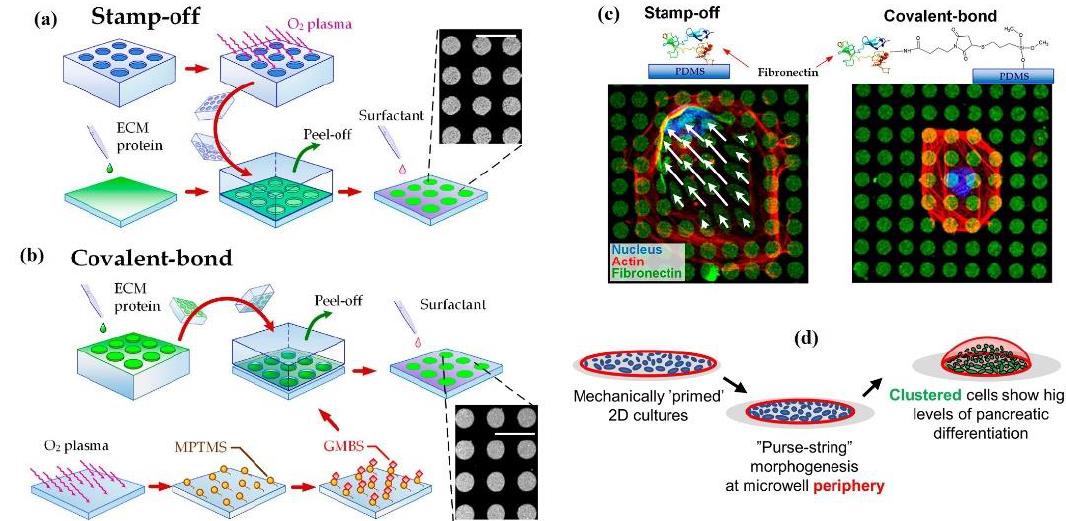
Figure 5. Micropatterning . ( a ) Microcontact printing ( μ CP) of ECM proteins for achieving different protein–substrate adhesion using stamp-off based on direct adsorption and ( b ) the covalent bond based on intermediate binding molecules. Scale bars in all insets: 10 μm. (MPTMS—3-mercaptopropyltrimethoxysilan; GMBS—N-γ-maleimidobutyryloxysuccinimide ester) ( c ) ECM protein delamination in cell spreading regions on micropatterned fibronectin layers. Arrows indicate displacements of the fibronectin micro islands. Scale bar: 12 μm. (Reproduced with permission from [49]) ( d ) Proposed mechanism of action for increased PDX1 expression via collective actin “purse-string” contraction. (Reproduced with permission from [53] under Creative Commons Attribution 4.0 International License).